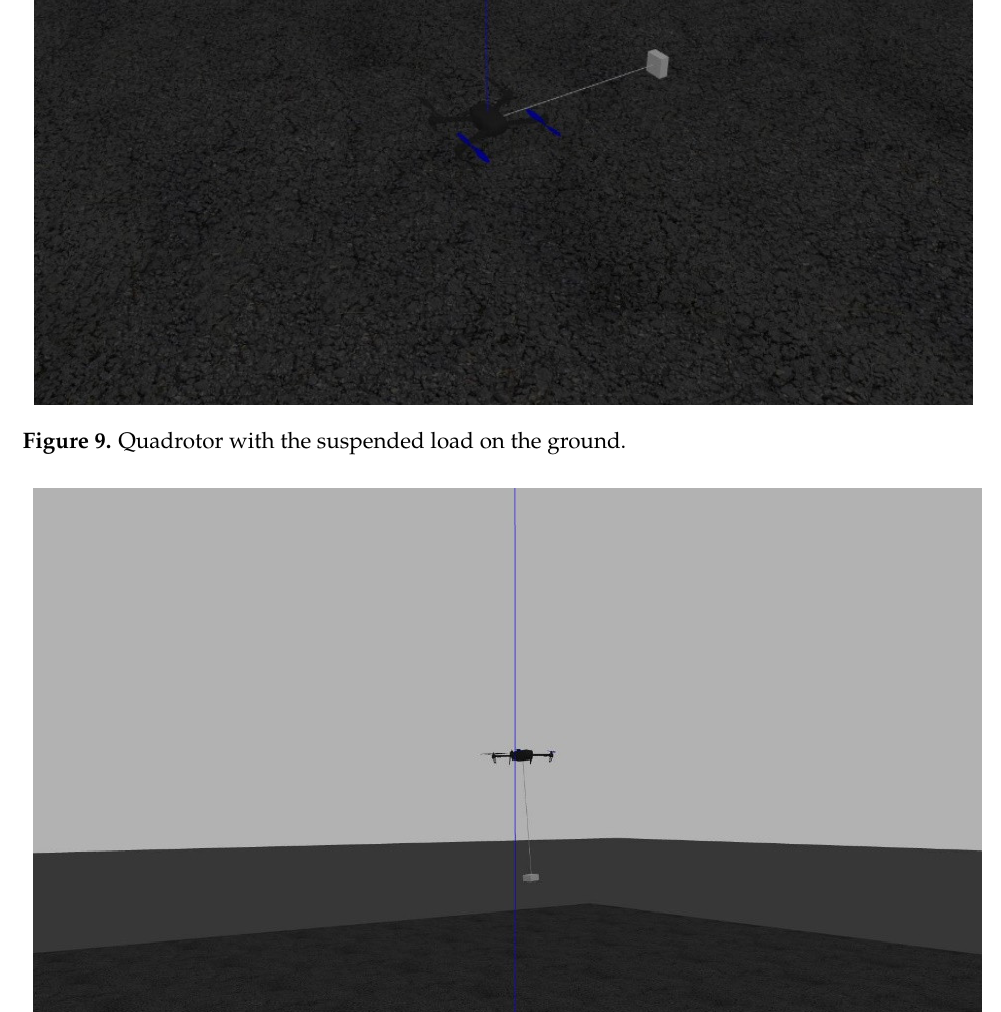
Figure 10. Flying quadrotor with the suspended load